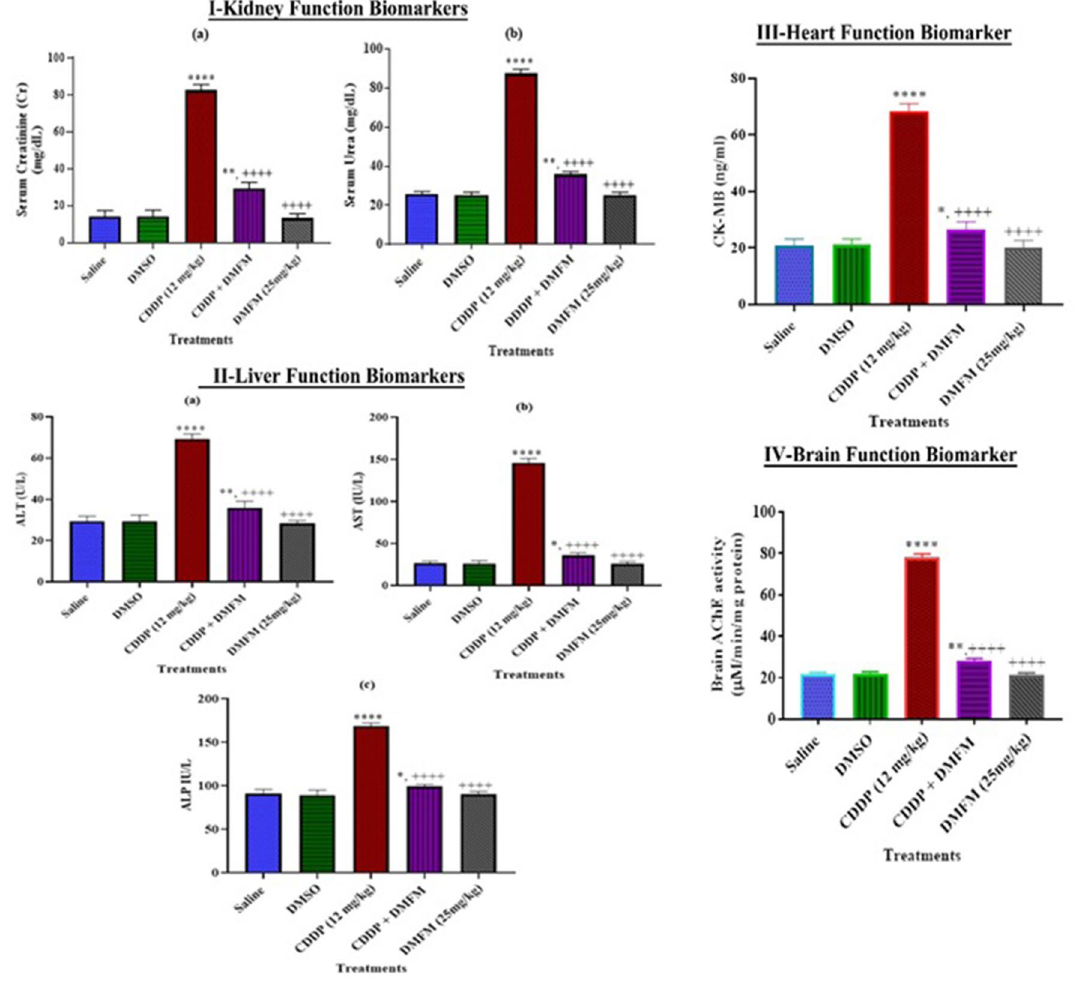
Figure 2. Effect of DMFM administration on organ injury biomarkers. Data presented as Mean ± SEM ( n = 7). *, **** p < 0.05 and P < 0.0001 versus saline respectively, and ++++ P < 0.0001 versus CDDP. Data were analyzed by One-way ANOVA combined with Tukey’s multiple comparison tests.